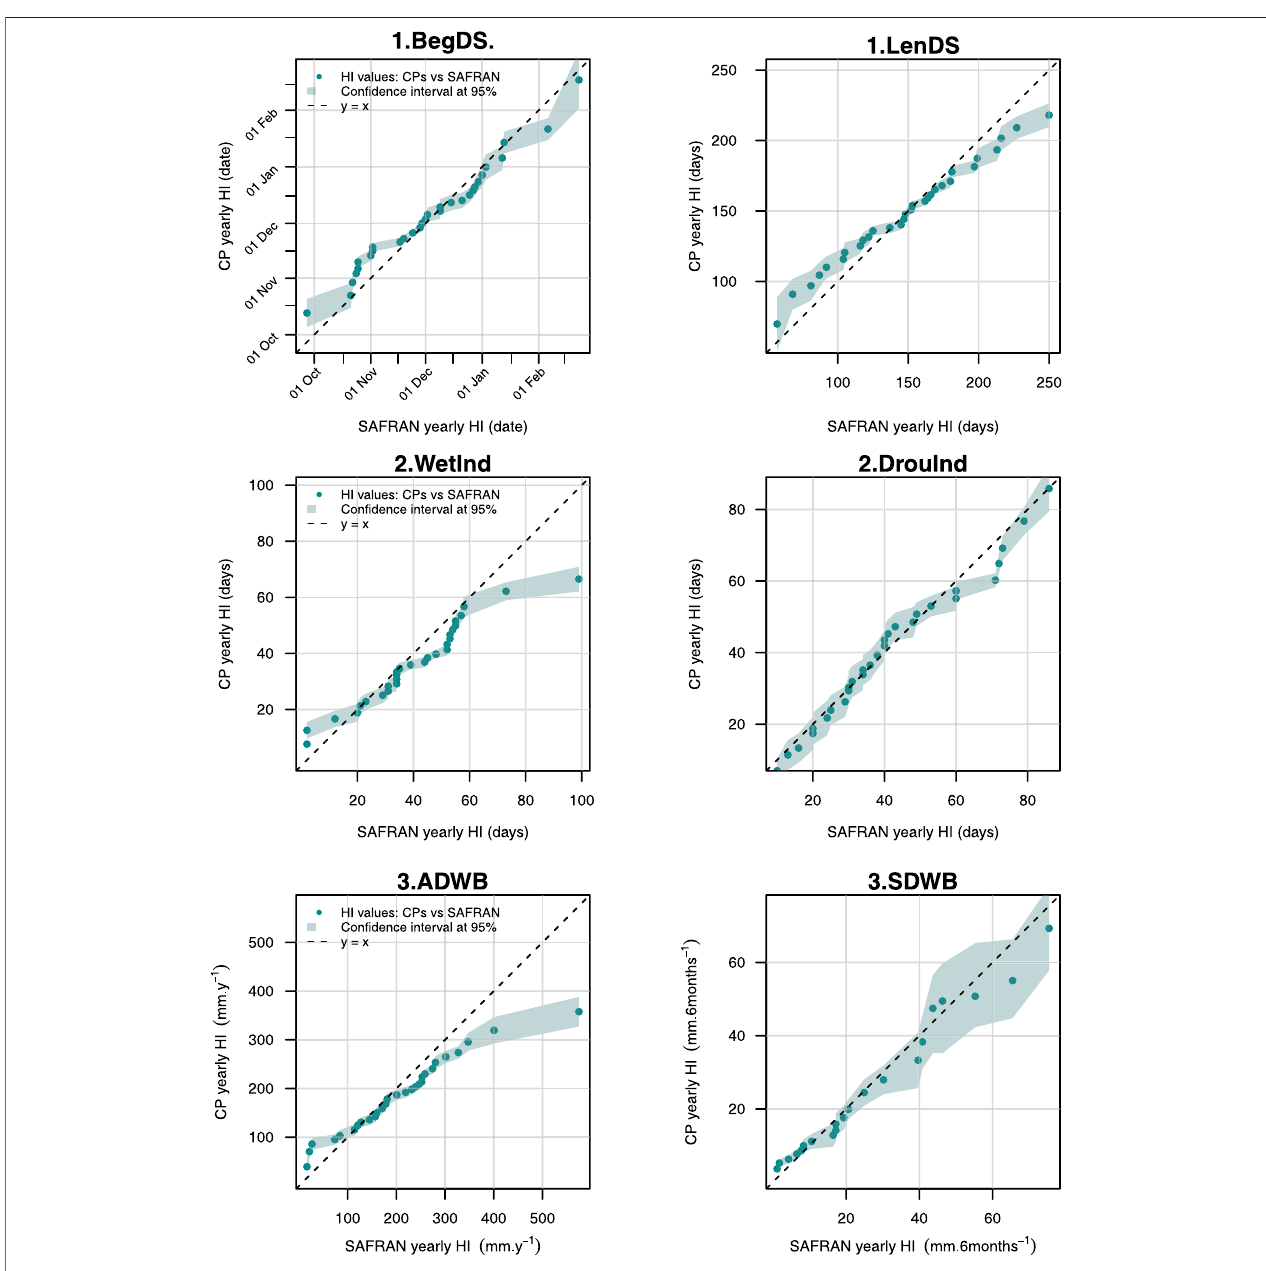
FIGURE3| DistributionfunctionsofHIsfromCPscomparedtothosefromSAFRANinthehistoricalperiod(1975 – 2004)forthreeclassesofHIs: “ Temporalityofthe drainage season ” , “ Water content in the storage ” and “ Drained water balance ” . The distribution functions of HI CP_HIST from CPs were calculated as the mean of distribution functions of HI CP_HIST from the 12 CPs studied ( Table 1 ). The abbreviated names of each HI referred to in the graphics are available in Table 2 .